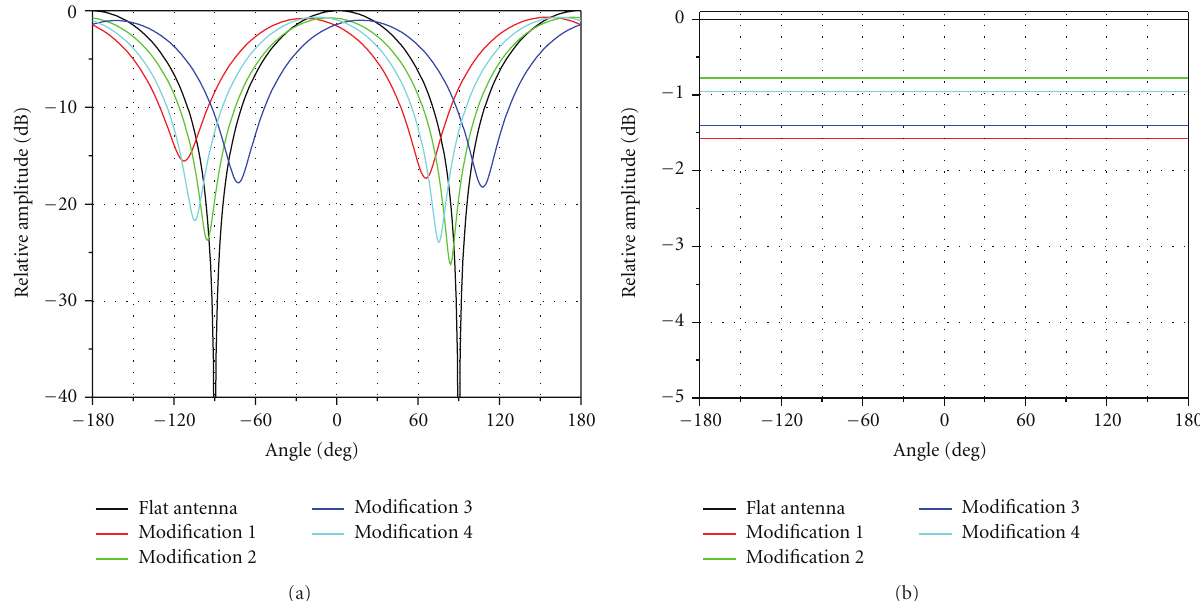
Figure 5: Radiations patterns for the conventional patch antenna: (a) radiation pattern in E-plane, (b) radiation pattern in H-plane.